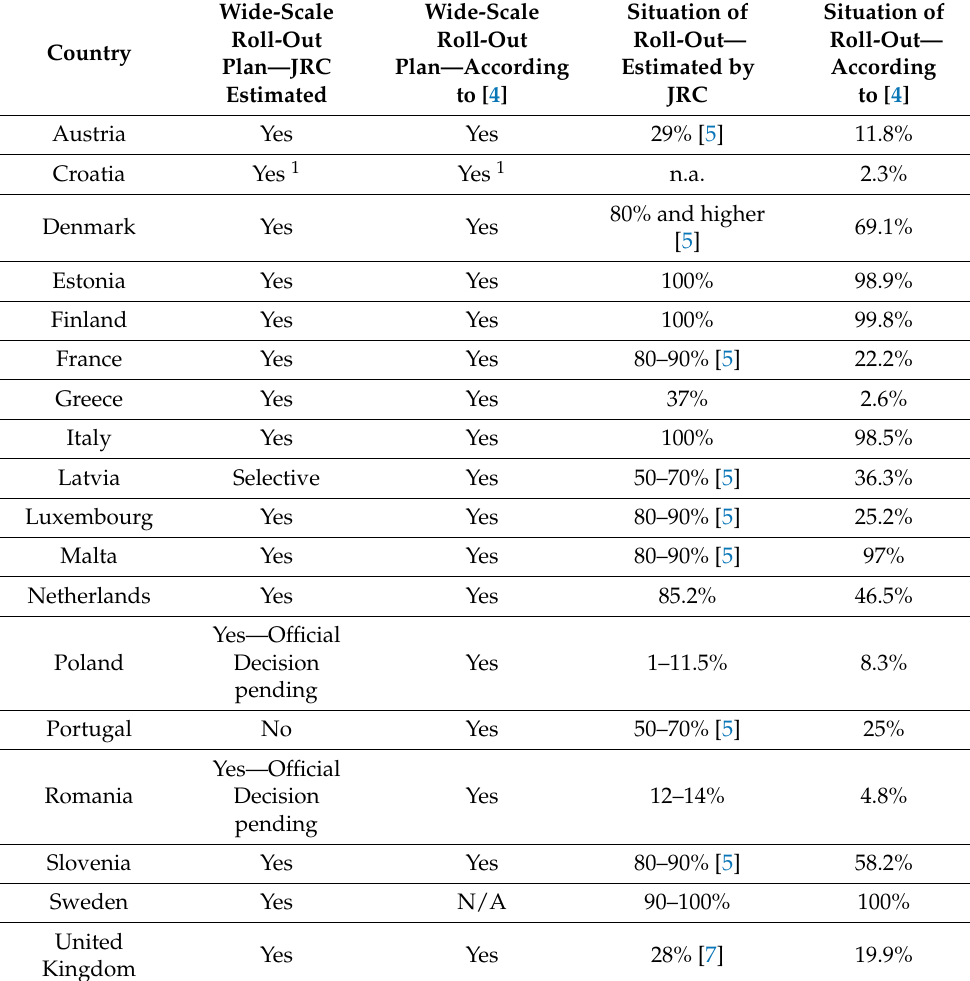
Table 1. Status of smart metering roll-out in countries that decided for a wide-scale roll-out, Source: [2], unless otherwise stated. Wide-Scale Country